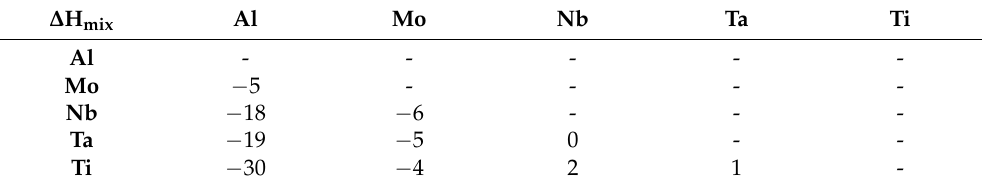
ing point (T Ta = 3290 K, T Mo = 2896 K, T Nb = 2750 K, T Ti = 1914 K, T Al = 933 K). The zones rich